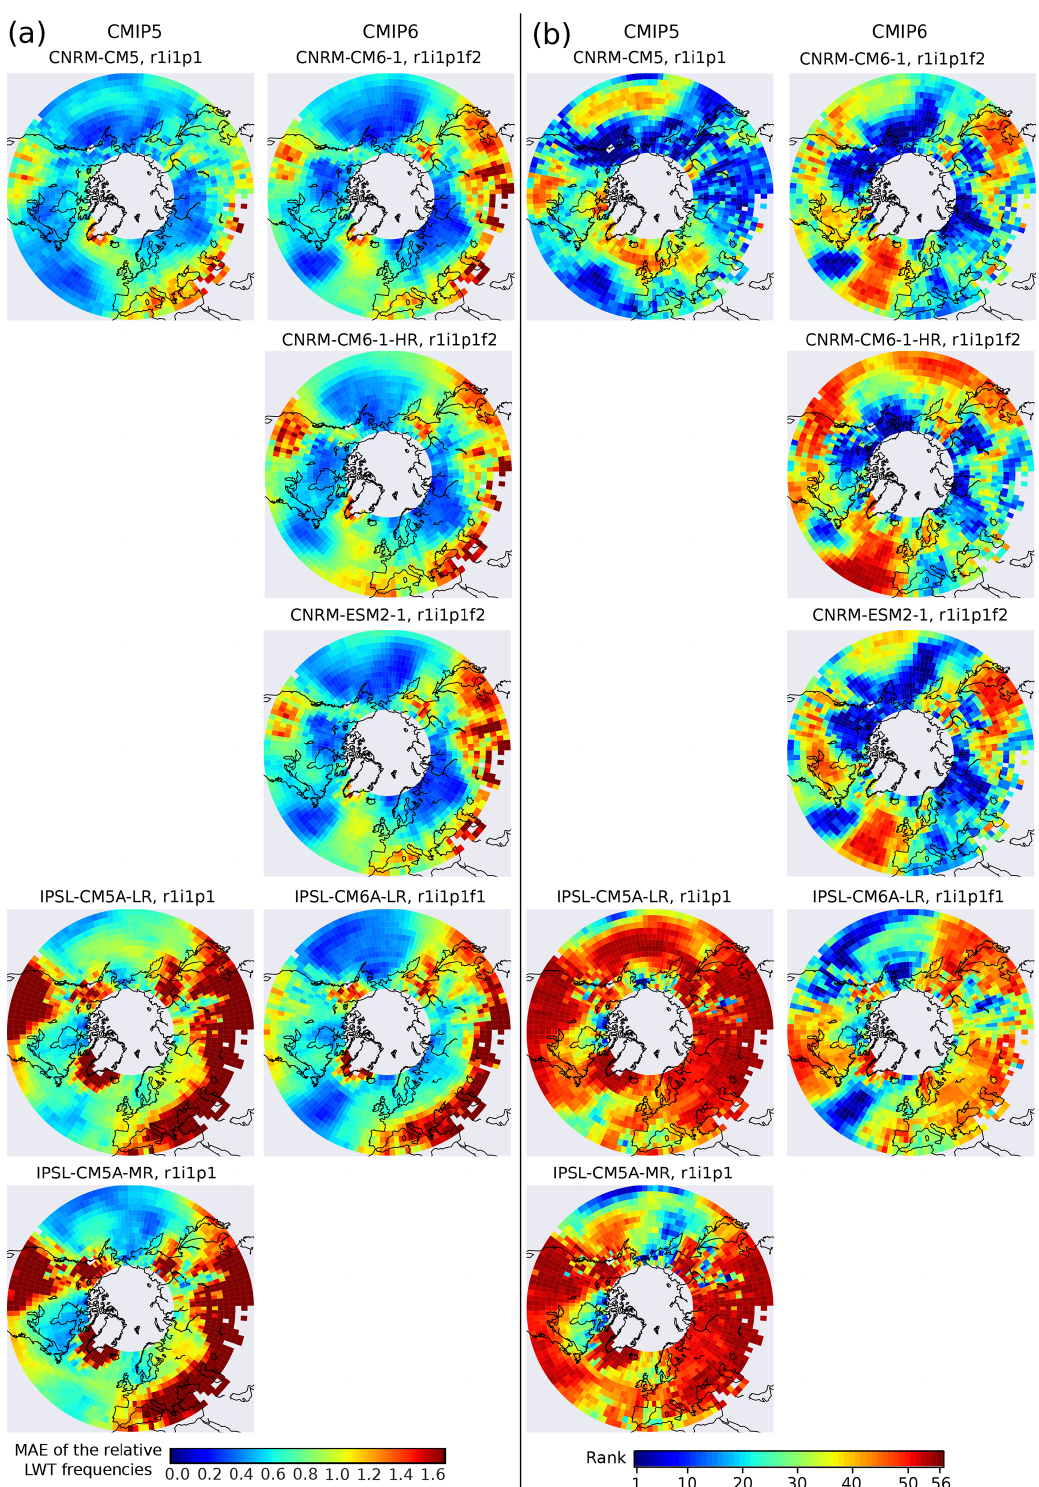
Figure 5. As Fig. 3 but for the CNRM and IPSL